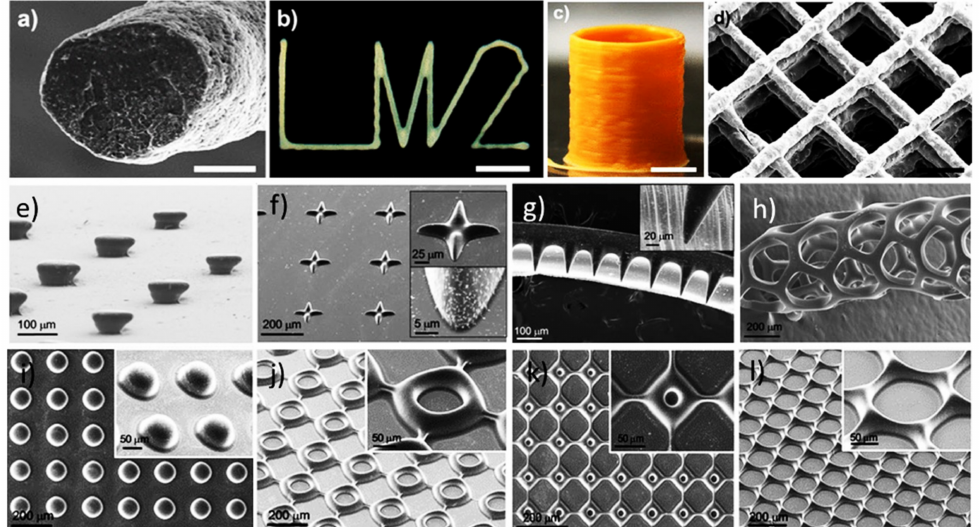
Figure 10. Structures fabricated via photopolymerization using piezoelectric nanocomposite